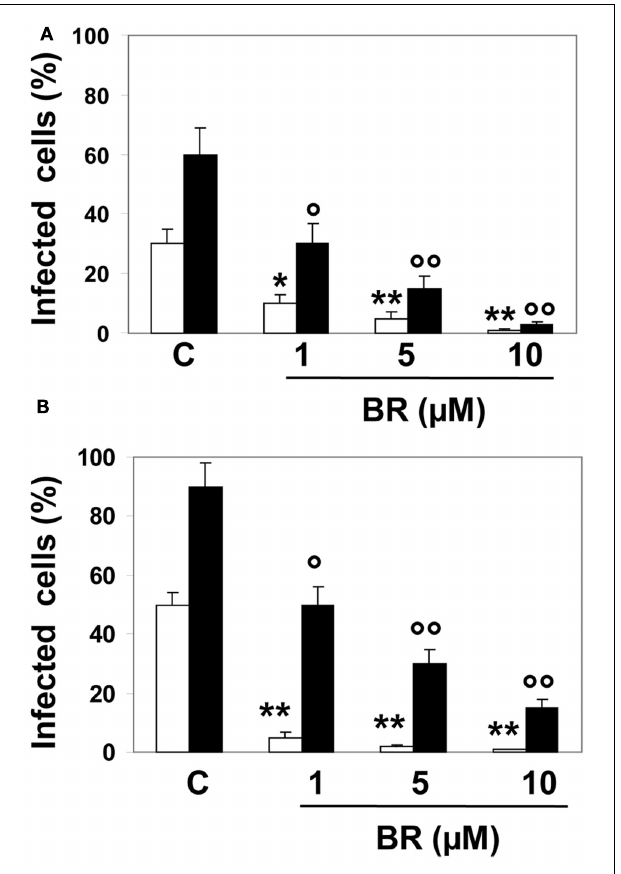
FIGURE 1 | Effect of bilirubin (BR) on herpes simplex virus type 1 (HSV-1) and enterovirus EV71 replication. Hep-2 (A) andVero (B) cells were pre-incubated with BR (1–10 μ M) for 2h. At the end of incubation, BR was removed and Hep-2 andVero cells infected with HSV-1 and EV71, respectively, both at the titer 1 × 10 5 PFU. After 2h, the inocula were removed and the cells incubated in culture medium for 24 (white columns) or 48h (black columns). Data are expressed as the percentage of infected cells, mean ± SEM of six individual samples per group. * P < 0.05 and ** P < 0.01 versus control (C) after 24h from infection; ˚ P < 0.05 and ˚˚ P < 0.01 versus control after 48h from